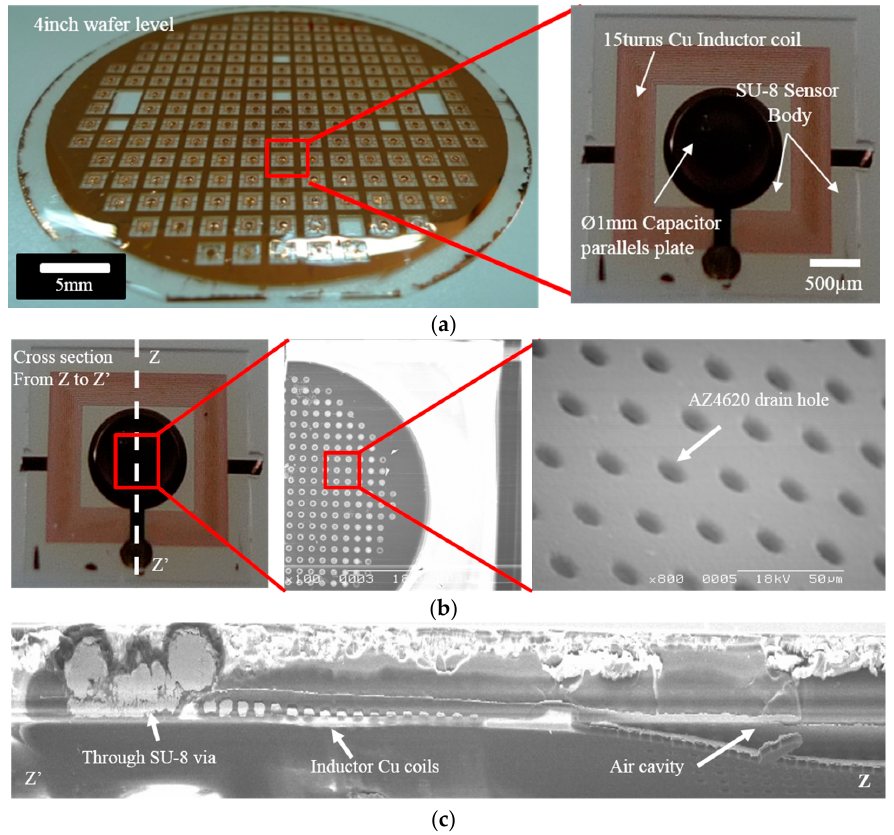
Figure 4. ( a ) The actual photo images; ( b ) SEM images; and ( c ) cross-sectional view of wireless pressure sensor.